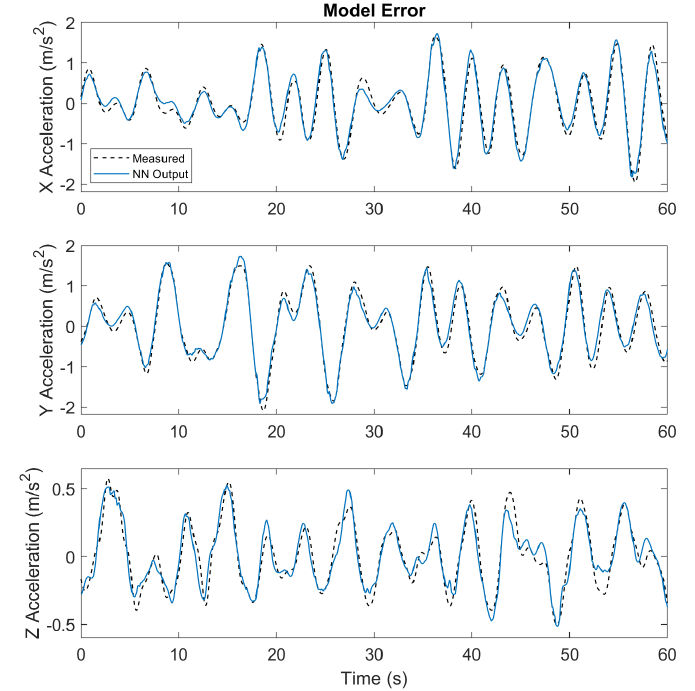
Figure 10. Comparison of neural network model prediction output and measured data for linear accelerations from the F330 quadrotor